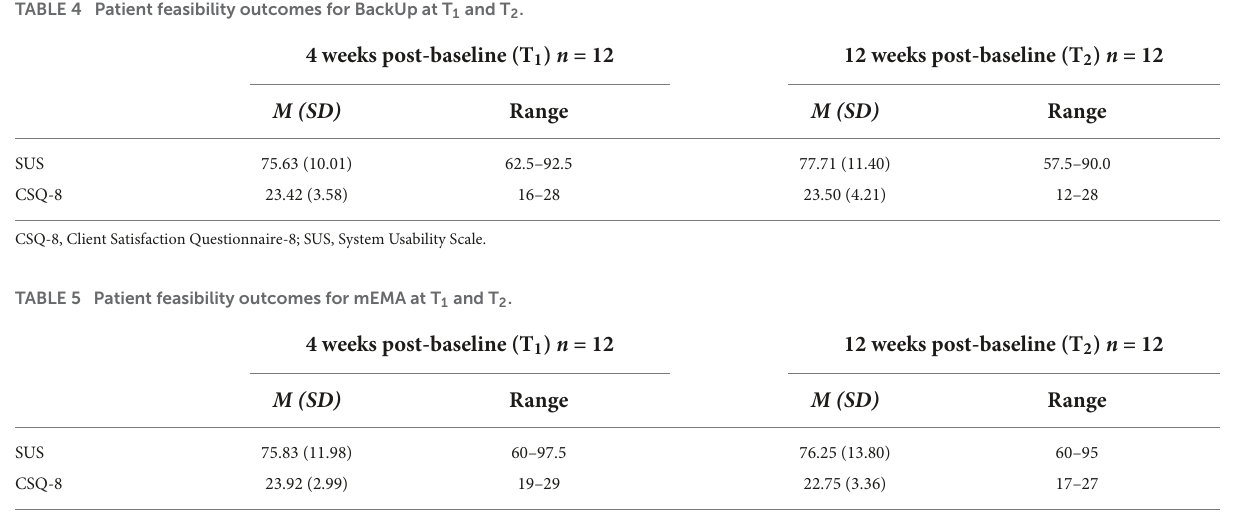
TABLE 4 Patient feasibility outcomes for BackUp at T 1 and T 2 .